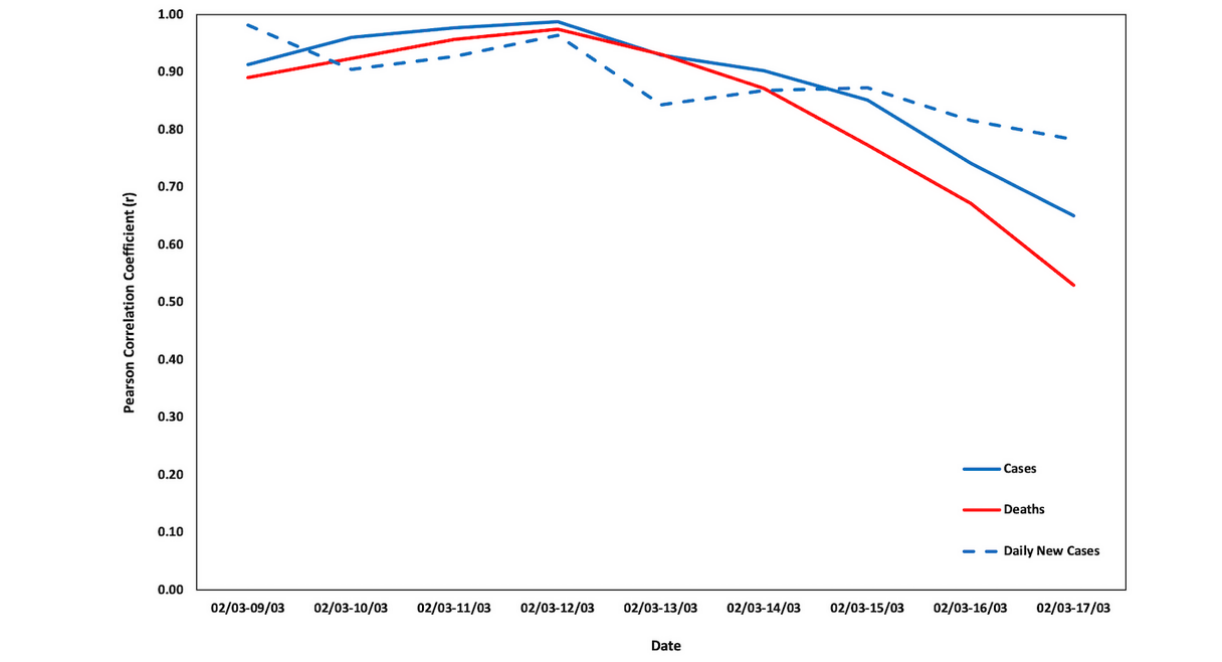
Figure 6. Changes in the Pearson correlation coefficients ( r ) for Spain.